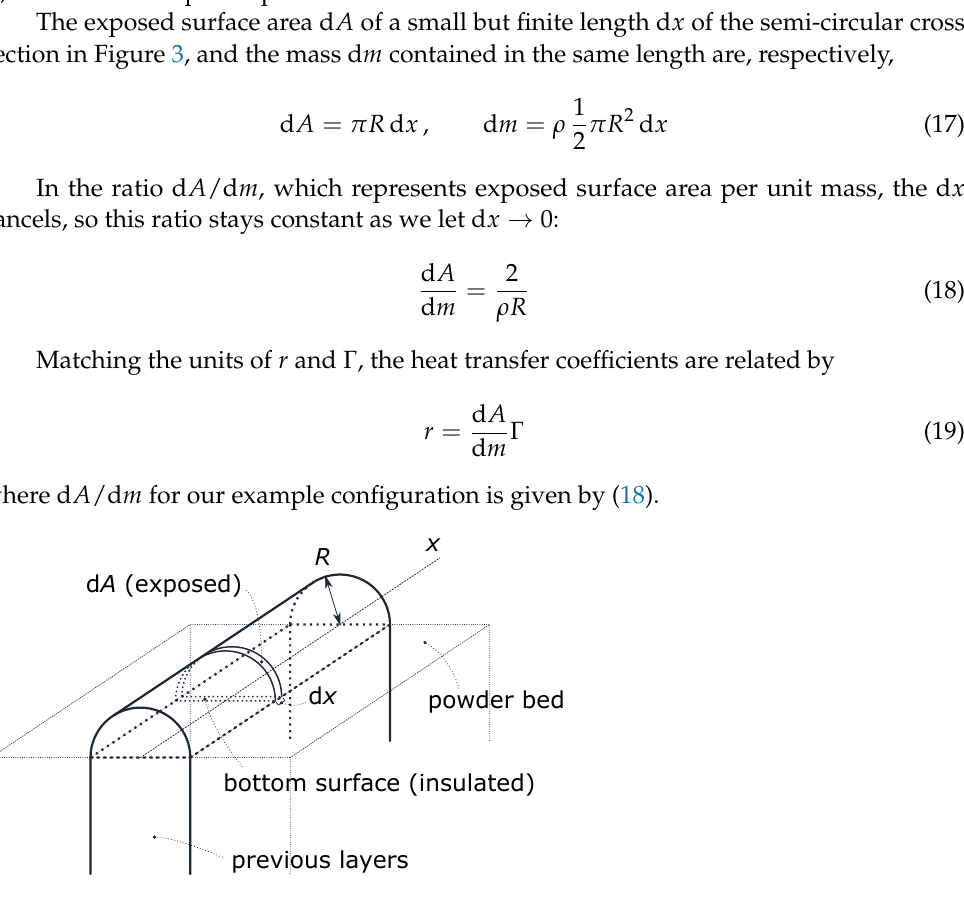
Figure 3. Example configuration for the cooling model: printed layer with semi-circular cross